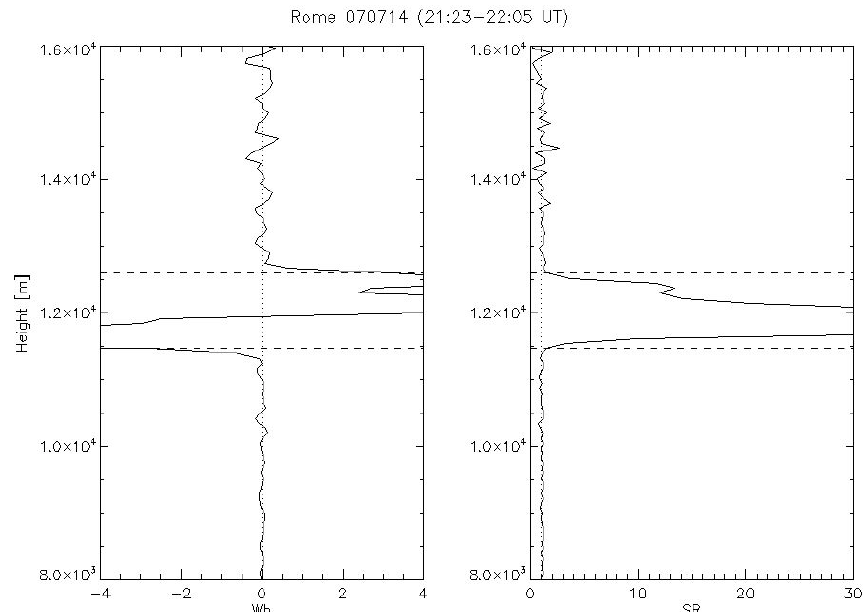
Figure 2. SR(z) profile (right panel) for a cirrus observed during the night of 5/07/2012, between 21:23 and 22:05 UT with the corresponding W b (z) profile. The dashed horizontal lines on the left panel mark the inflection points of W b to which correspond the bottom (11469 m) and the top (12519 m) of the cirrus on the right panel.